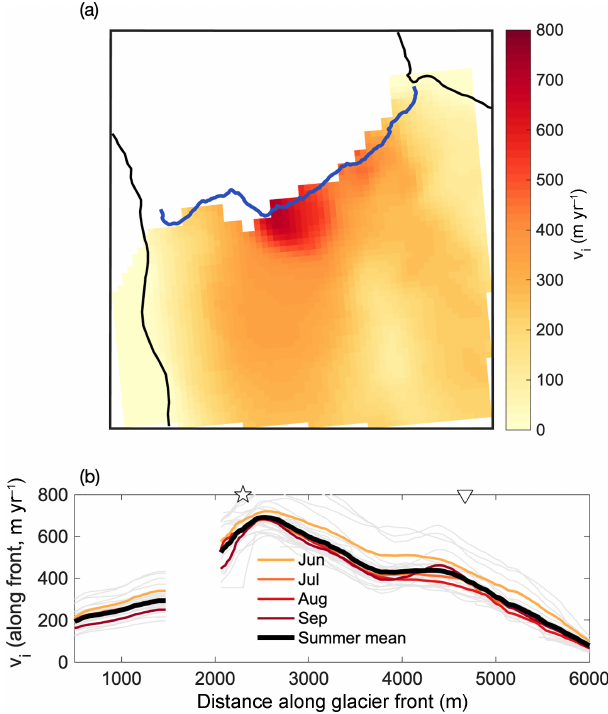
Figure 2. (a) InSAR ice velocity data near the glacier front. Shown are mean summer (June–September) values averaged over 28 veloc- ity fields, collected during 2012–2014. Note that there is a consis- tent data gap near the promontory. The shading represents the hor- izontal velocity magnitude. (b) Velocity profiles along the glacier front. Here, as in all figures, the orientation is looking down-glacier. The faint gray lines show the 28 individual velocity fields. Also in- dicated are the approximate locations of the two plumes ( , (cid:79)